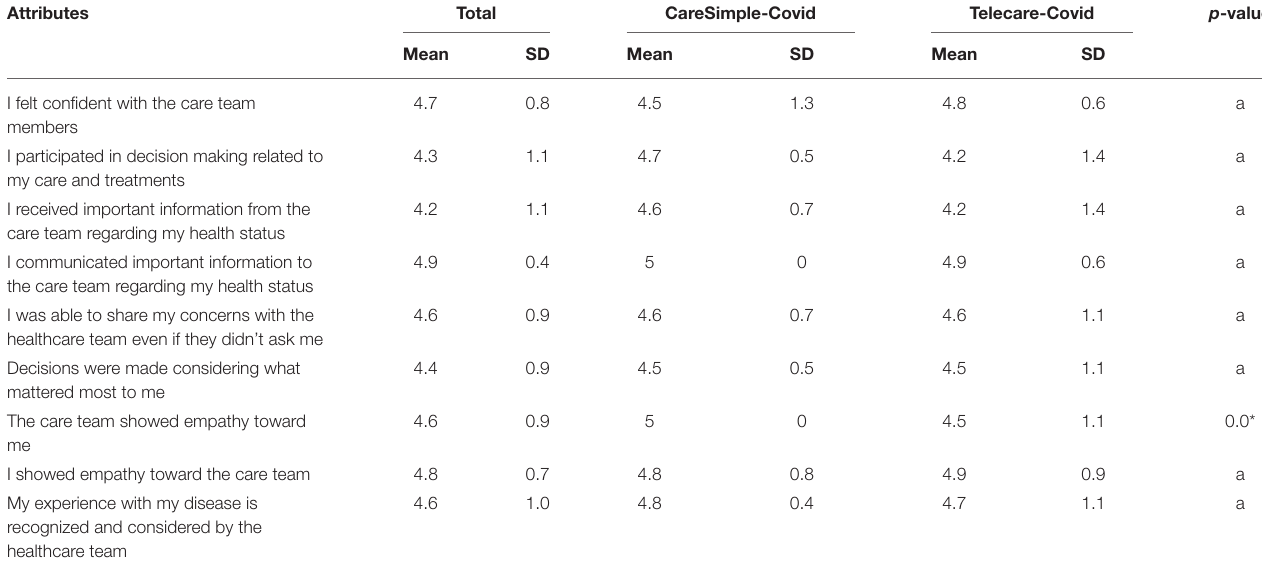
TABLE 5 | Mean and SD of patient perceptions of engagement in care and the medical team (overall and specific to each platform). Attributes Total CareSimple-Covid